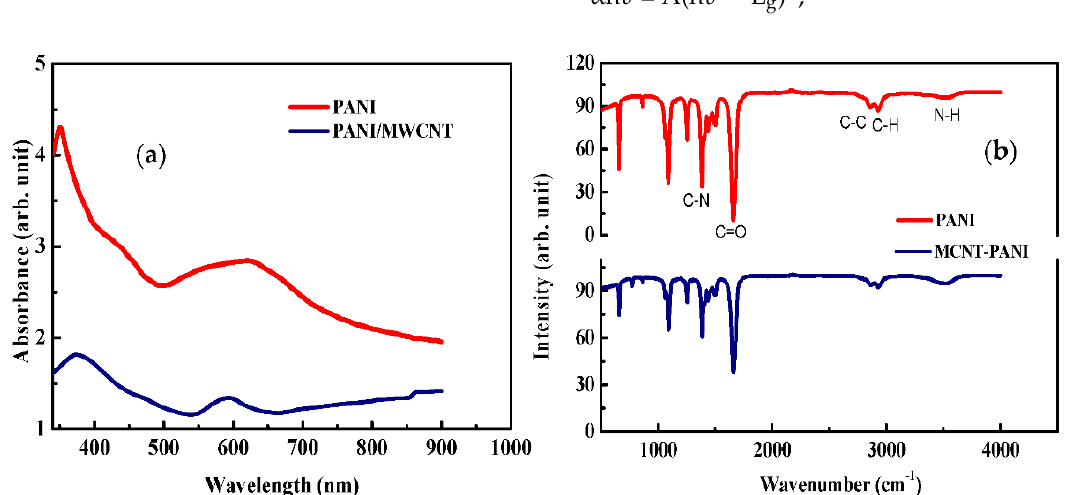
Figure 3. ( a ) UV − Visible of PANI and PANI/MWCNT in DMF and ( b ) Infrared spectroscopy of PANI and MWCNT − PANI in DMF.